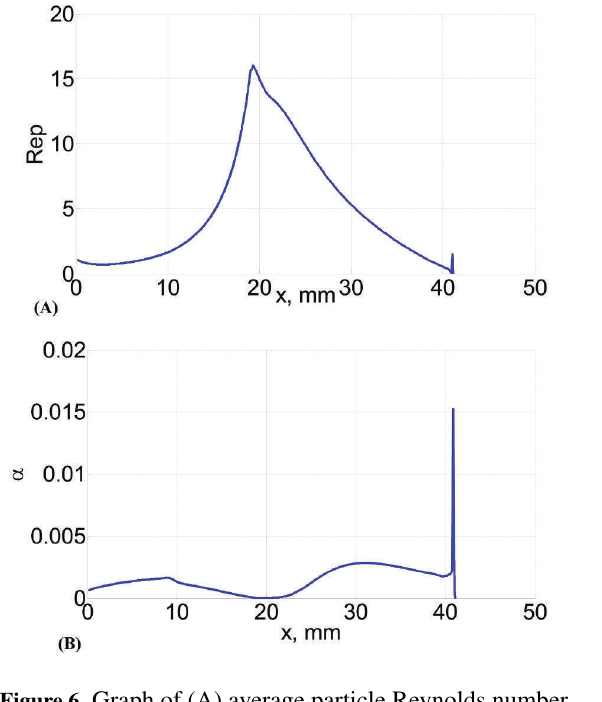
Figure 6. Graph of (A) average particle Reynolds number, Re p , and (B) shear rate, ˛ , vs. distance along the nozzle axis.